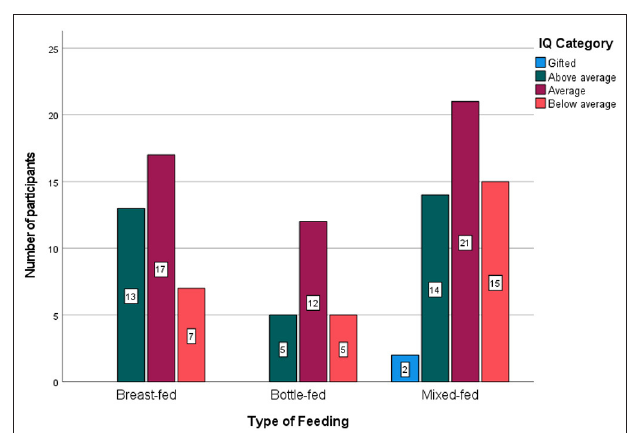
FIGURE 2 | Intelligence quotient (IQ) levels among breastfed, bottle-fed, and mixed-fed groups.